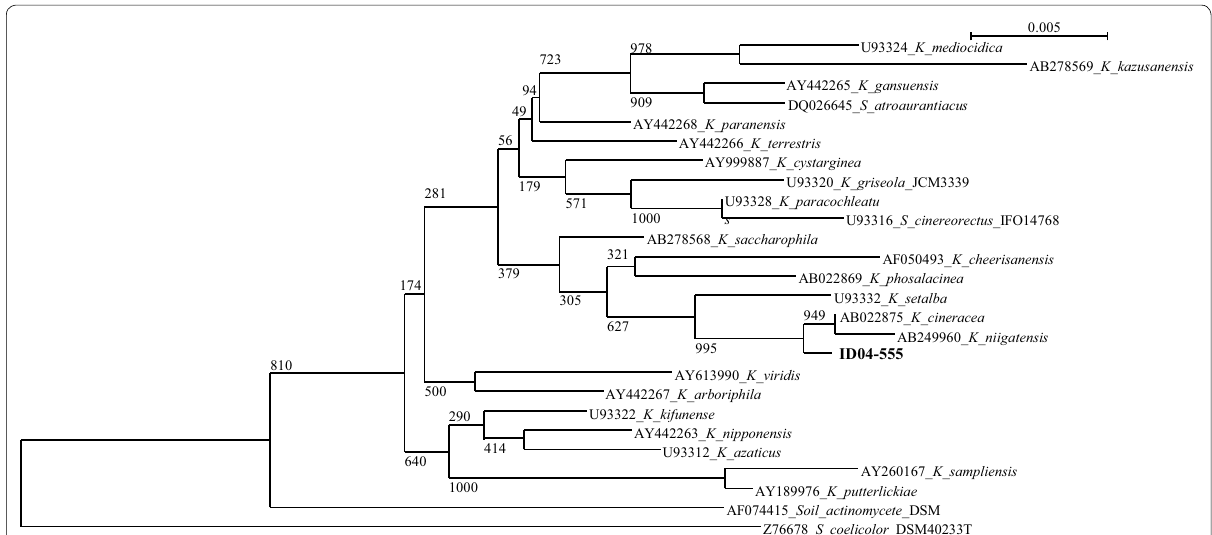
Fig. 2 Neighbor‑joining phylogenetic tree of genus Kitasatospora and positions of ID04‑0555 strain (KY576672_ K _BTCC B‑806) based on 16S rRNA gene sequence analysis. Bootstrap values (>50 %) based on 1000 replicates are shown at the branch nodes. The sequence of Streptomyces coeli- color DSM 40233 T was used as the outgroup. Bar 0.005 substitutions per nucleotide position. Representative sequences in the dendrogram were